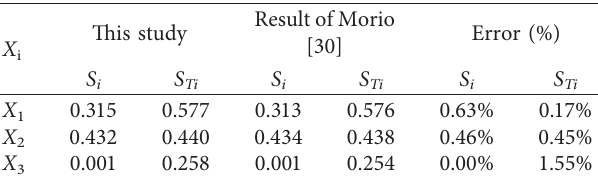
Table 2: Mean estimation with 10,000 Monte Carlo samples of the first and total Sobol’s indices.